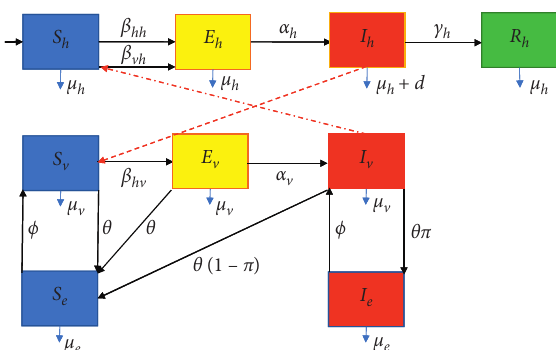
Figure 1: The flowchart represents the interactions and transfer of vector-borne disease in both human and vector populations. The host population is split into the following states: susceptible S h , exposed E h , infectious I h , and recovered R h . The vector population is split into three states: susceptible S v , exposed E v , and infectious I v . The egg population is split into two states: susceptible S e and infectious I e . Dashed arrows show the direction of transmission between humans and